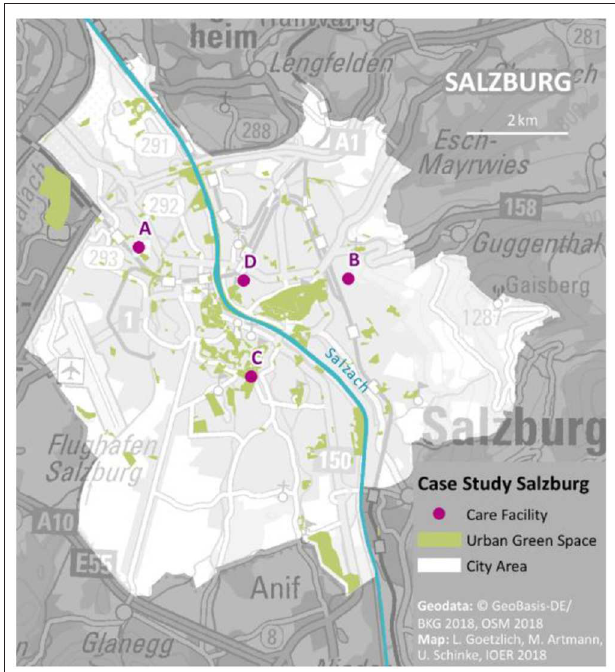
FIGURE 1 | The case study Salzburg and surveyed care